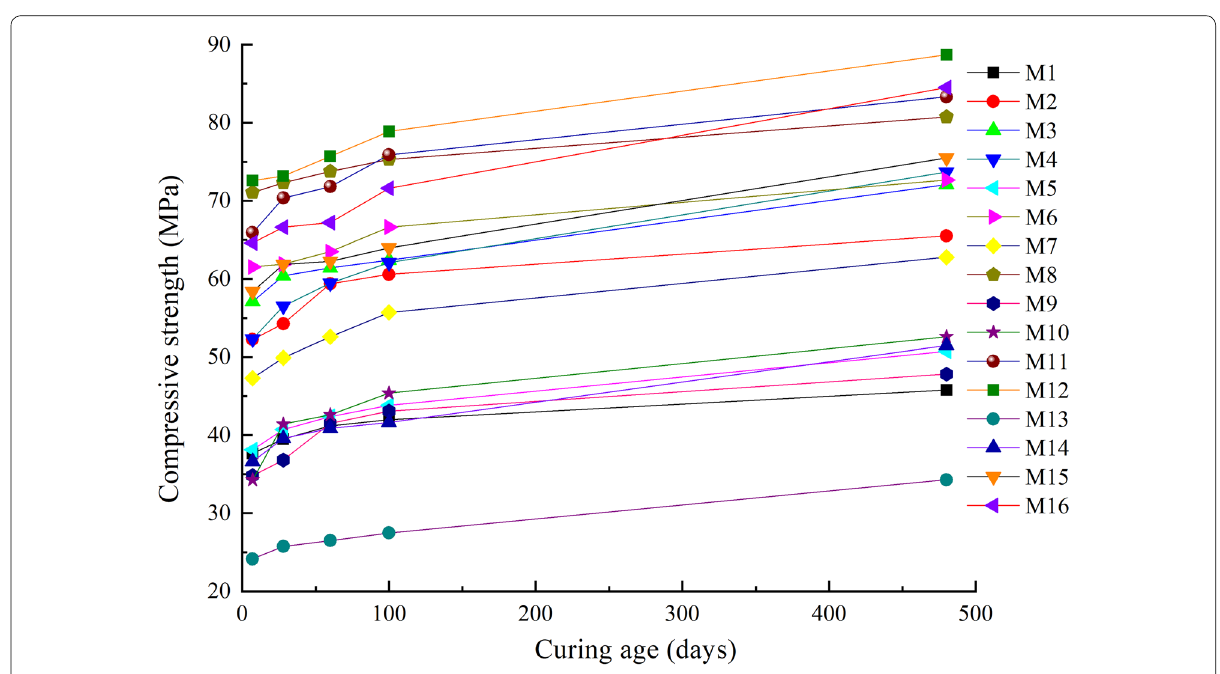
Fig. 3 Compressive strength development of FAGC after initial heat curing.